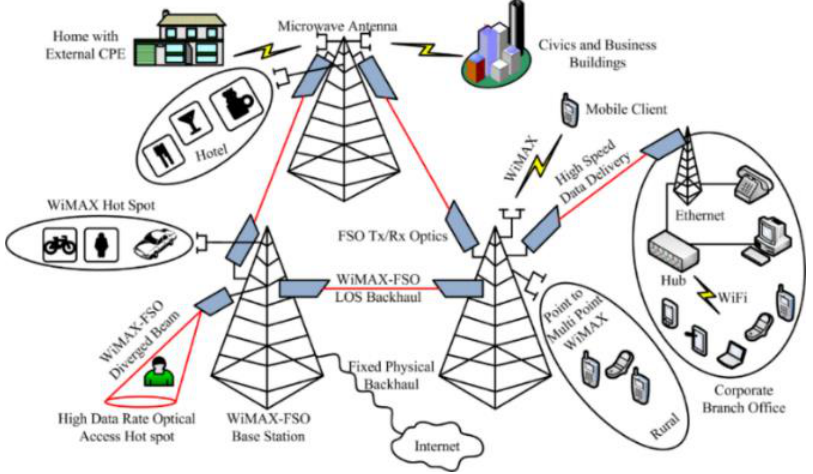
Figure 26. FSO-communication-supported WiMAX architecture.